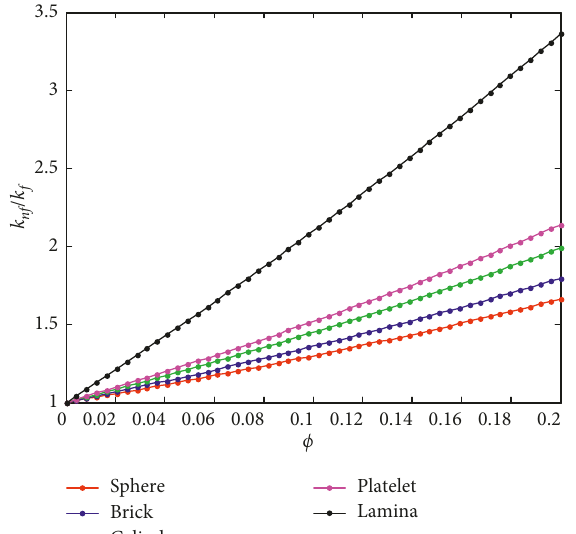
Figure 3: Effects of nanoparticle shape on thermal conductivity ratio of the nanofluid.